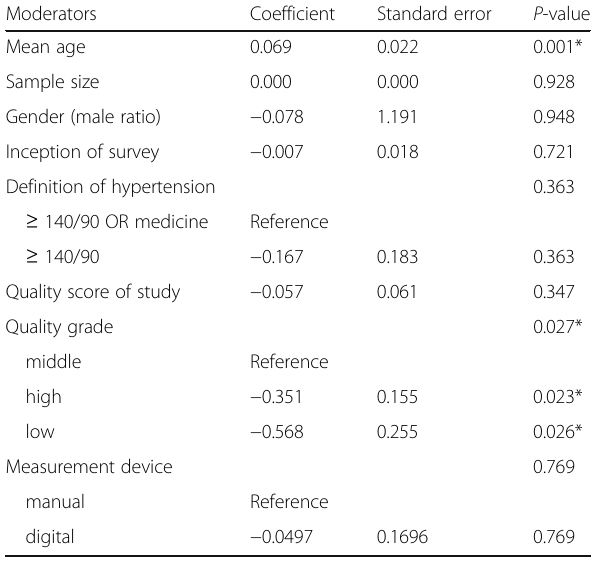
Table 3 Results of the meta-regression